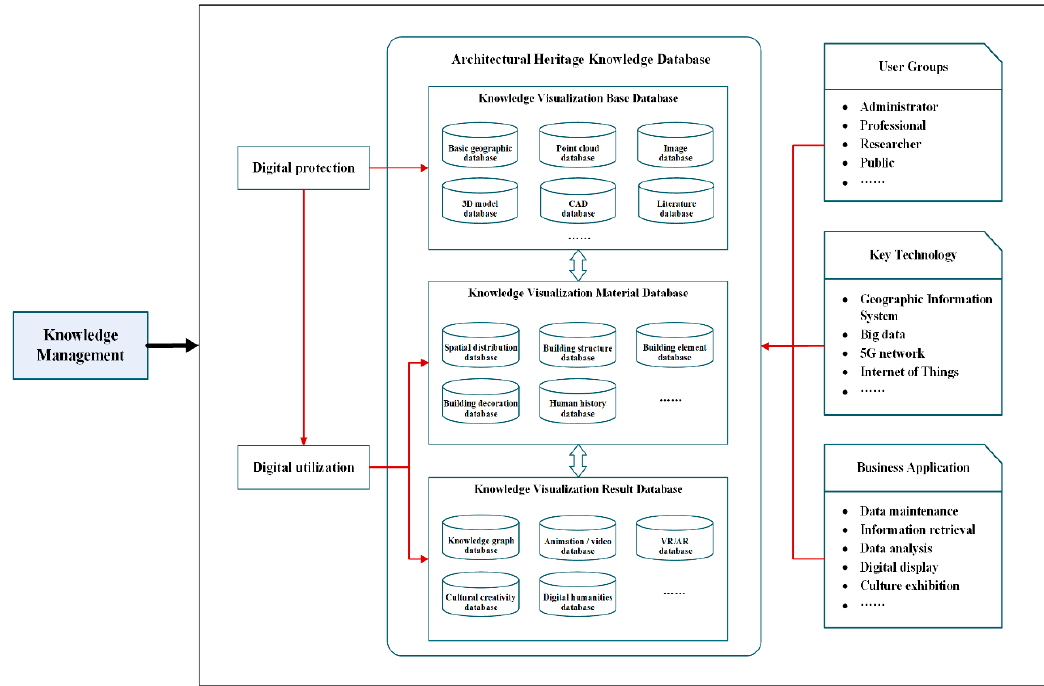
Figure 5. Technical framework of the knowledge management. The contents of the architectural heritage knowledge database were as